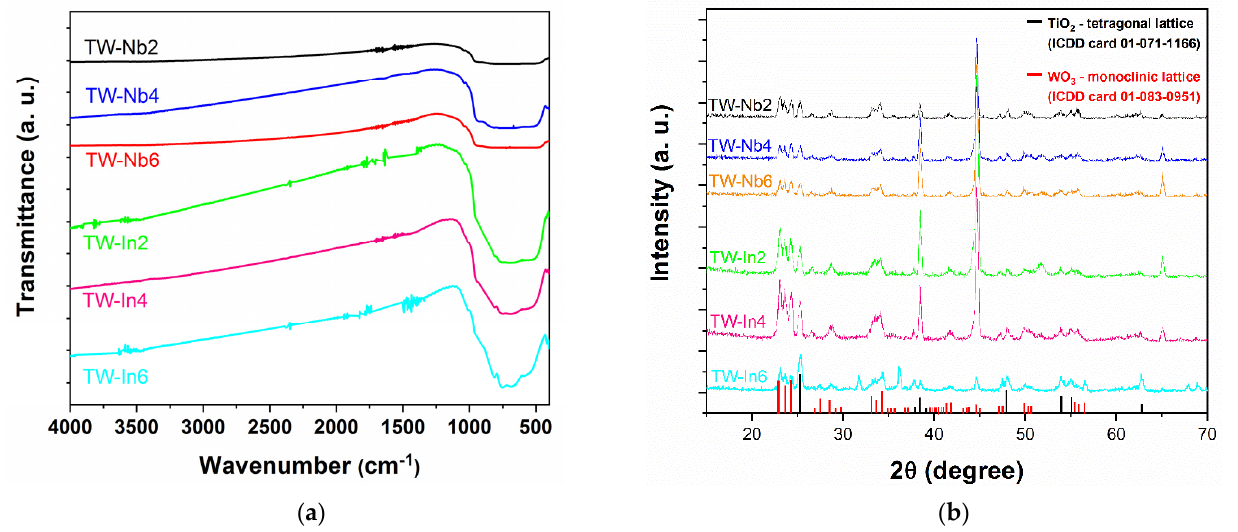
Figure 4. ( a ) FTIR spectra and ( b ) XRD patterns of all TW − Nb and TW − In sintered MMO, varying dopant concentrations. The X-ray diffractograms of the sintered TW-Nb and TW-In MMOs are presented in Figure